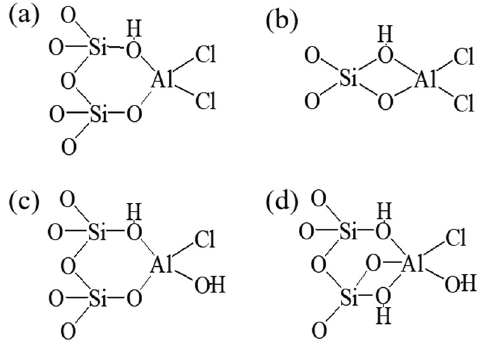
Figure 6: E ff ect of AlCl 3 concentration on the catalytic performance of AlCl 3 /H β . Reaction conditions: n ( 2 - MN ) : n ( PA ) = 1:1.8, TS 10g, AlCl 3 /H β ( re fl ux for 8h and calcination at 550°C for 3h ) 3g, 190°C,